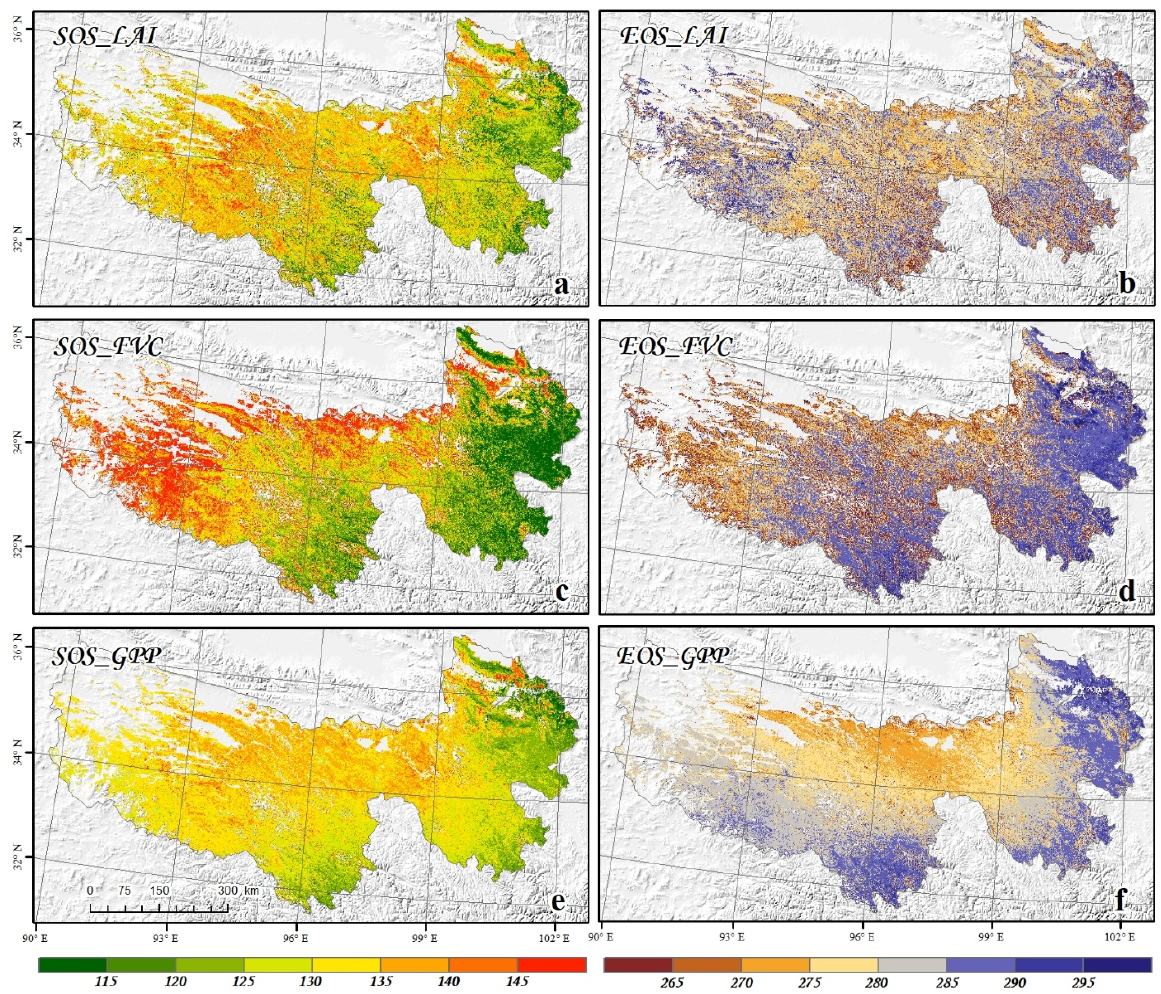
Figure 5. Spatial patterns of the land surface phenology derived from ( a , b ) LAI, ( c , d ) FVC, and ( e , f ) GPP in 2018 across TRSR. The left panels display the start of the growing season, and the right panels show the end of the growing season.